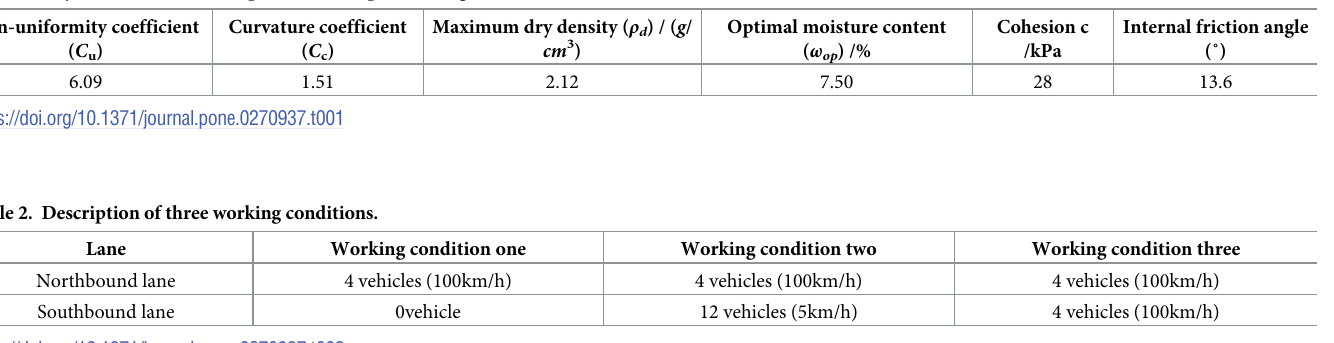
Table 1. Physical and mechanical parameters of pre-disintegrated carbonaceous